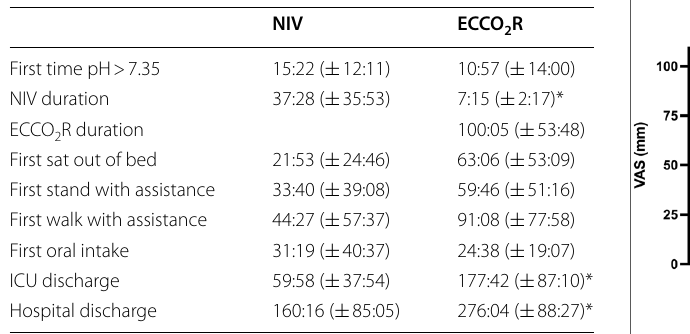
Table 2 Time to event following randomisation